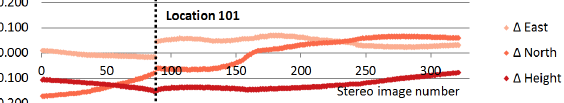
Figure 7. Deviations of projection centers in m for sequence 1.1